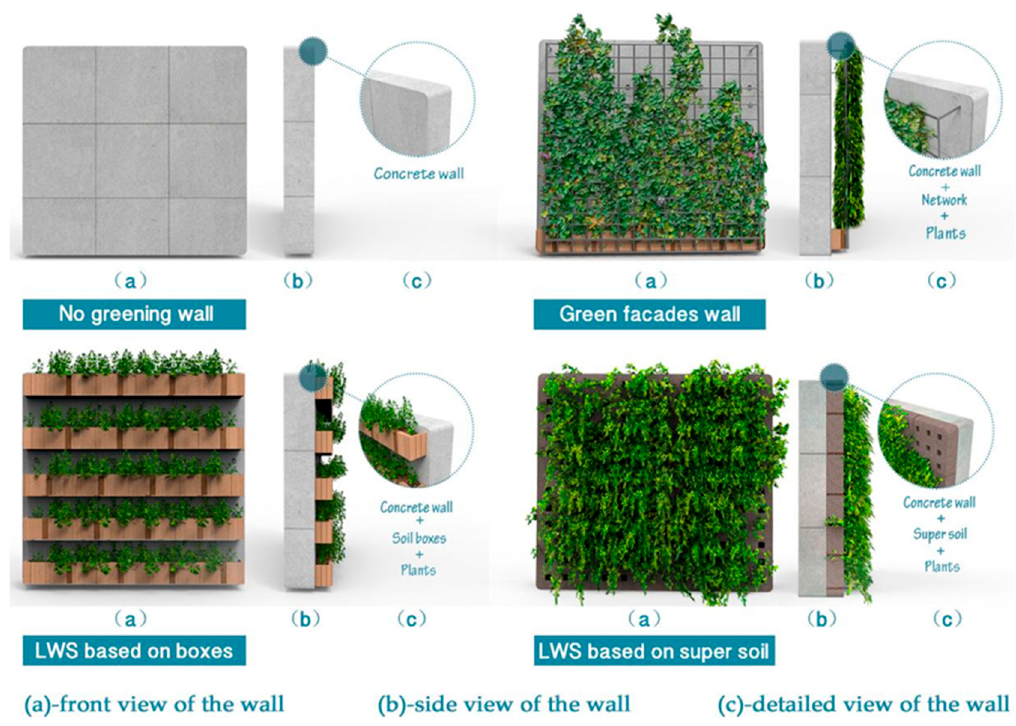
Figure 3. Abstract picture of four green walls.